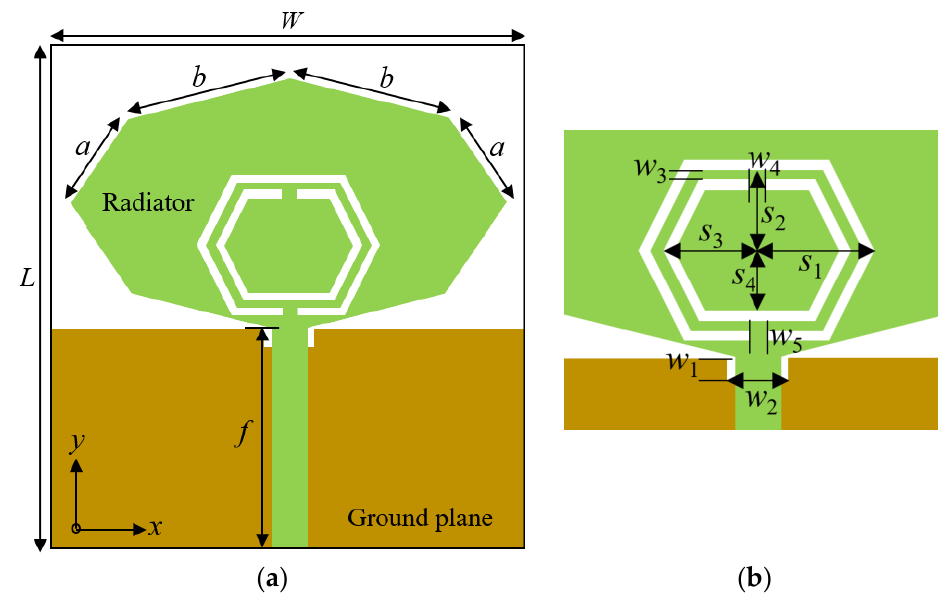
Figure 1. Proposed octagonal-shaped monopole antenna: ( a ) schematic layout; ( b ) enlarged view of the hexagonal-shaped complementary split-ring resonator (HCSRR). Table 1. Parameter details of the unit element and multiple-input-multiple-output (MIMO) antenna.